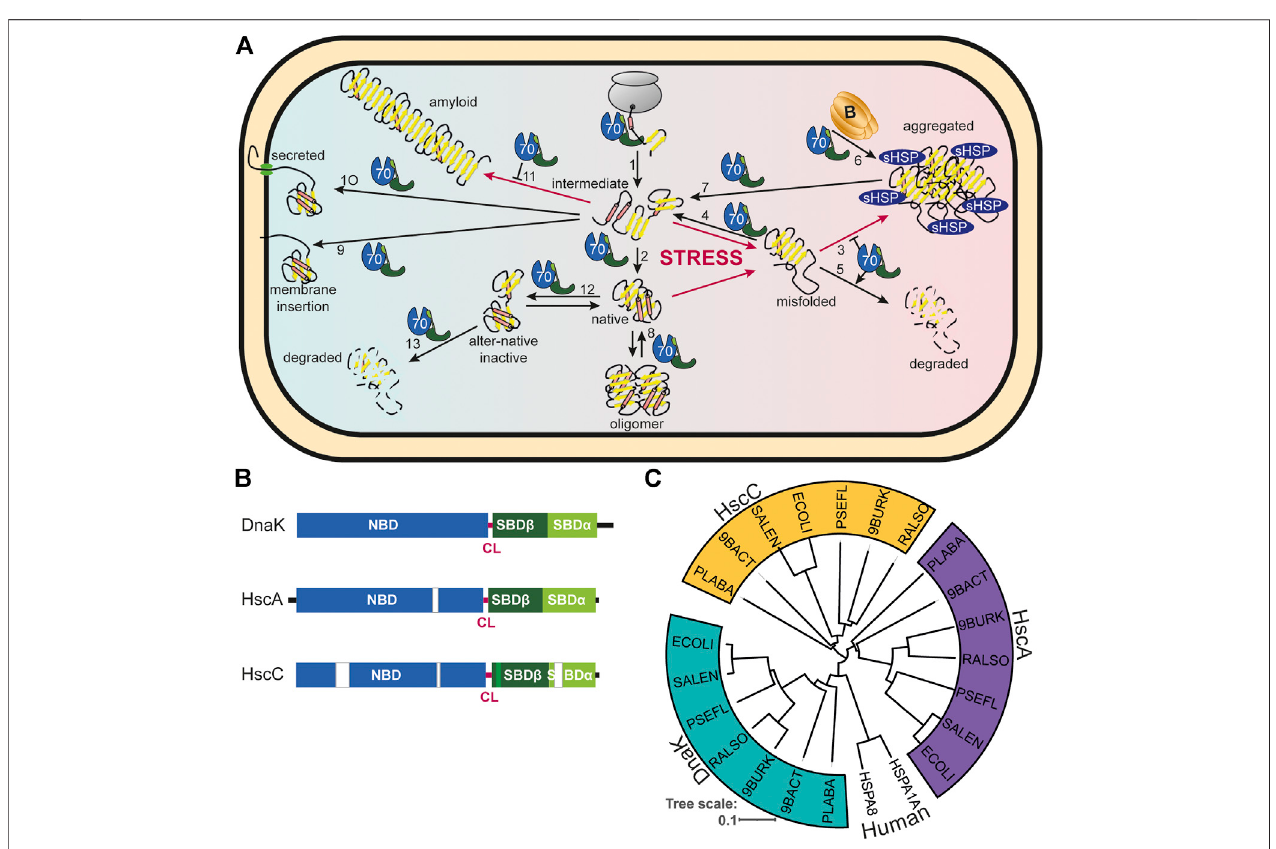
FIGURE 1 | Diversity of Hsp70s and their functions in prokaryotic cells. (A) , Diversity of functions of Hsp70s under optimal growth conditions (middle to left) and upon exposure to environmental and physiological stress (middle toright). Hsp70/DnaK (70) assists de-novo -folding ofproteins, interacting with nascent chains already at the ribosome (1) and with folding intermediates after release from the ribosome (2). Folding intermediates and even native proteins may misfold, in particular under stressconditions,andbecomeaggregationprone.Hsp70preventsaggregation(3)andrefoldsthemisfoldedproteinbyunfolding(4)ortargetitfordegradation(5). Under severe stress conditions protein aggregates are formed by coaggregation with sHSPs. Hsp70 targets ClpB (B) to the aggregates (6). ClpB solubilizes the aggregated proteins that are subsequently refolded by Hsp70 (7). Hsp70 disassembles homo-and heterooligomeric protein complexes like RepE-dimers and the λ O · λ P · DnaB complex (8). Proteins destined for insertion into the plasma membrane (e.g., DjlC) (9), or secretion into the periplasmic space (e.g., PhoA or curli) (10) are guidedbyHsp70andpreventedfromformingaggregatesoramyloid fi brils(curli)(11)inthecytoplasm.Hsp70alsointeractswithsomenativeproteinsliketheheatshock transcription factor σ 32 to keep them in an alter-native inactive conformation (12) and target them to degradation (13). (B) , Domain organization of the three types of Hsp70s that exist in prokaryotes, DnaK, HscA and HscC. NBD, nucleotide binding domain (blue); CL, conserved linker (magenta); SBD β , β -sandwich domain (dark green; light green: insertion in HscCs); SBD α , α -helical lid domain (chartreuse); black lines, C-terminal intrinsically disordered tails (for HscA also N-terminal extension); whitebars,largerdeletionsinNBDandSBDofHscAandHscCascomparedtoDnaK. (C) ,Phylogenetictreeofdifferentprokaryoticcladesthatcontainorganismswhich have all three Hsp70s. ECOLI, Escherichia coli ( γ -Proteobacteria); SALEN, Salmonella enteritidis ( γ -Proteobacteria); PSEFL, Pseudomonas fl uorescence ( γ -Proteobacteria); RALSO, Ralstonia solanacaearum ( β -proteobacteria); 9BURK, Paraburkholderia fungorum ( β -proteobacteria); 9BACT, Acidobacteria bacterium (unclassi fi ed Acidobacteria); PLABA, Planctomycetes bacterium (unclassi fi ed Planctomycetes); HSPA1A, human Hsp70; HSPA8, human Hsc70 (for comparison). A more extensive phylogenetic tree can be found in Barriot et al. (2020).